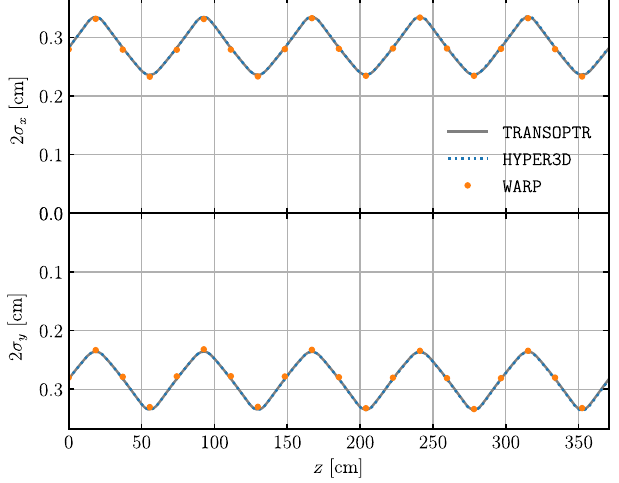
1. Root mean square transverse beam size over the first five FODO lattice periods for different